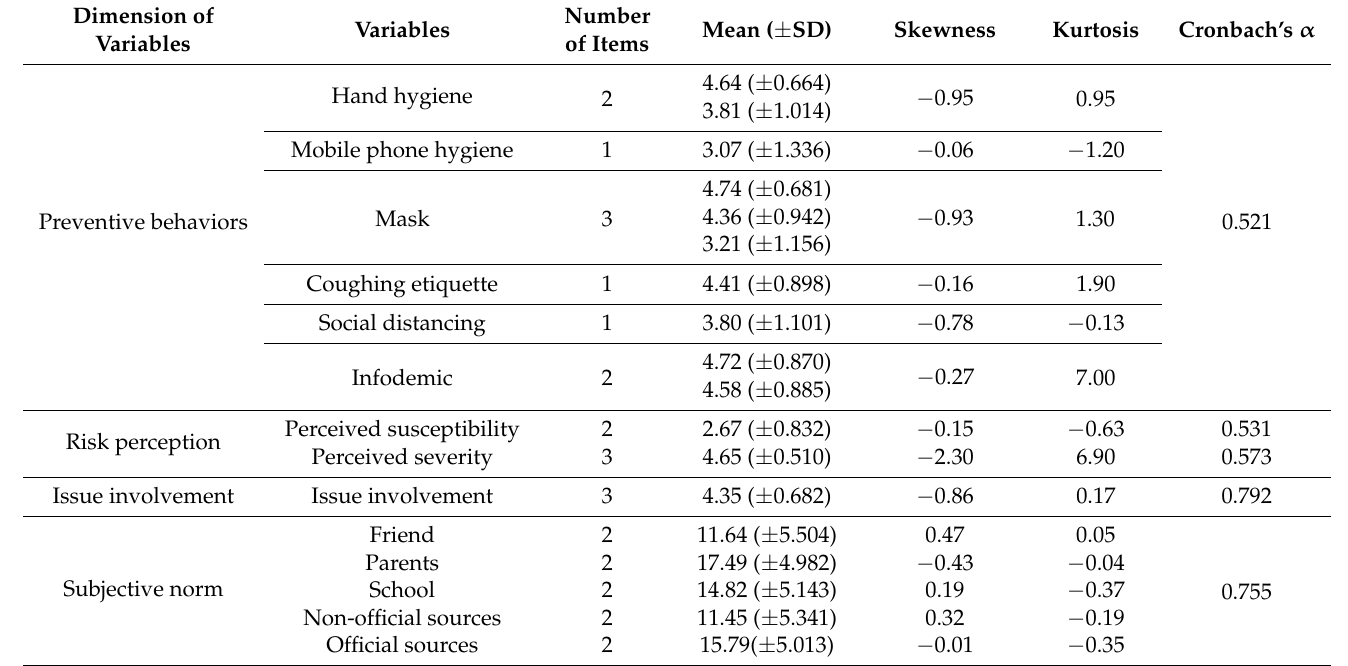
Table 2. Measurement of the study variables and reliability ( N = 239).